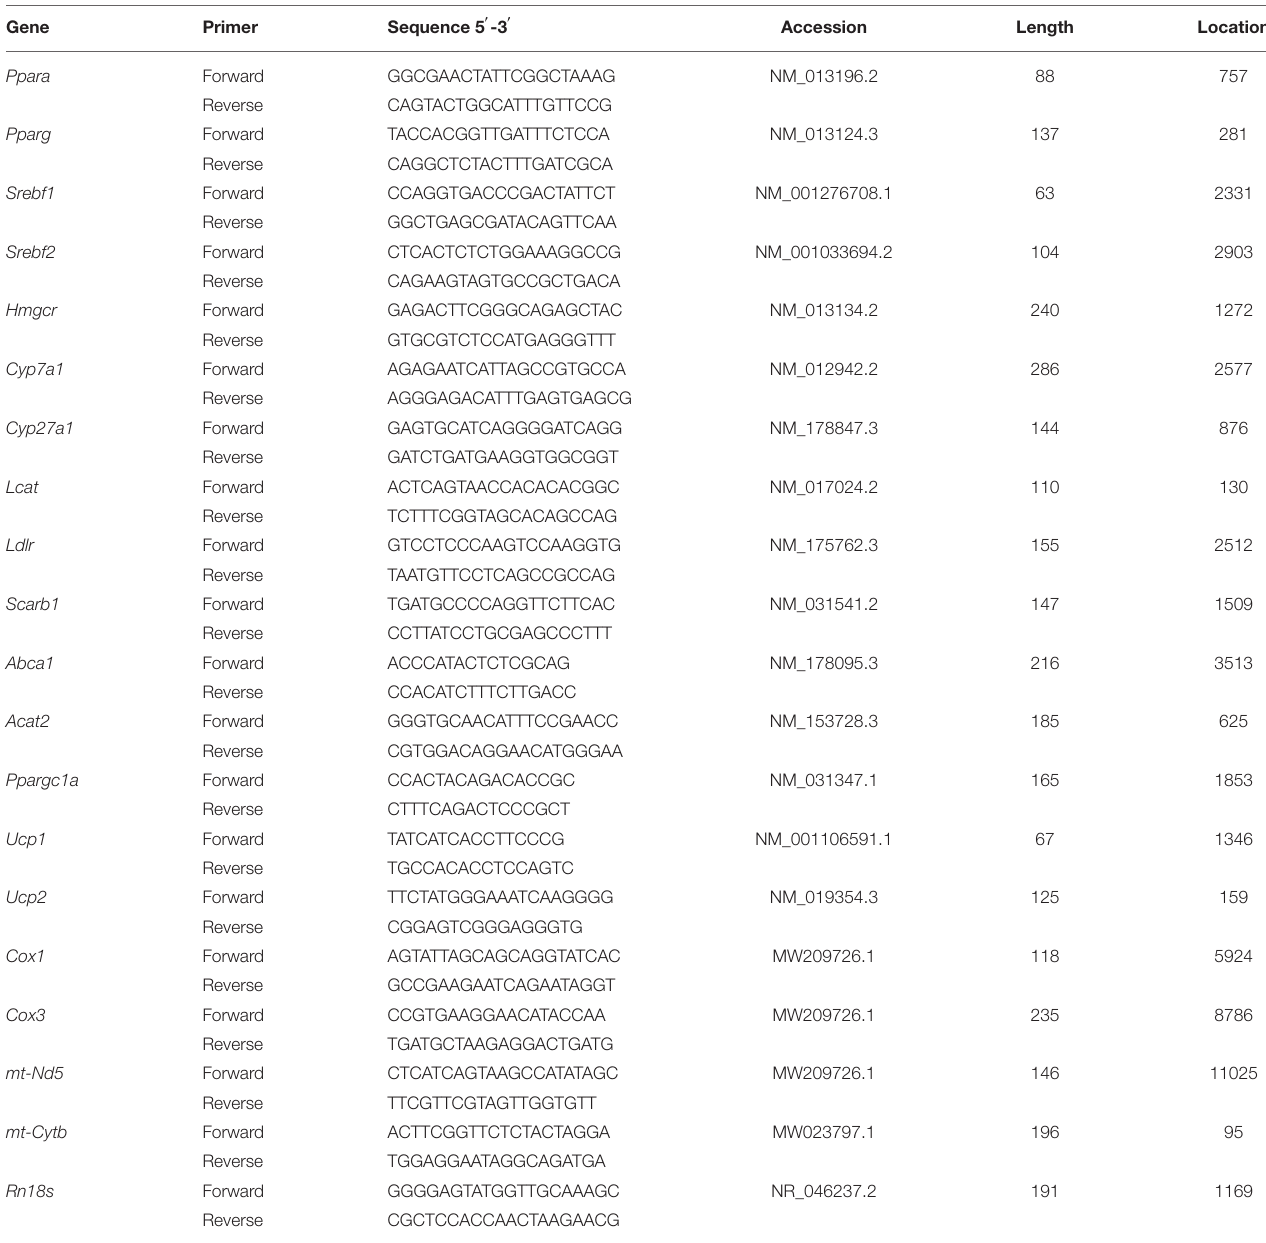
TABLE 2 | Primer sequences of the target and reference genes. Gene Accession Length